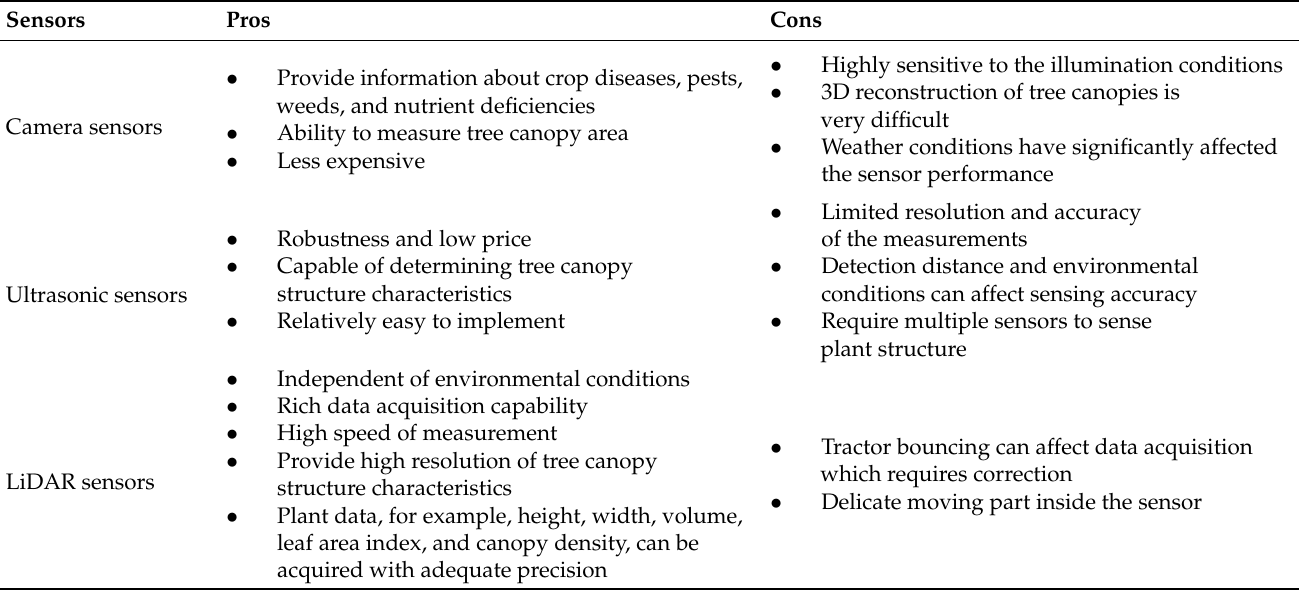
Table 6. Advantages and disadvantages of the different types of sensor applications for precision spraying (modified from [60]). Sensors Pros Cons